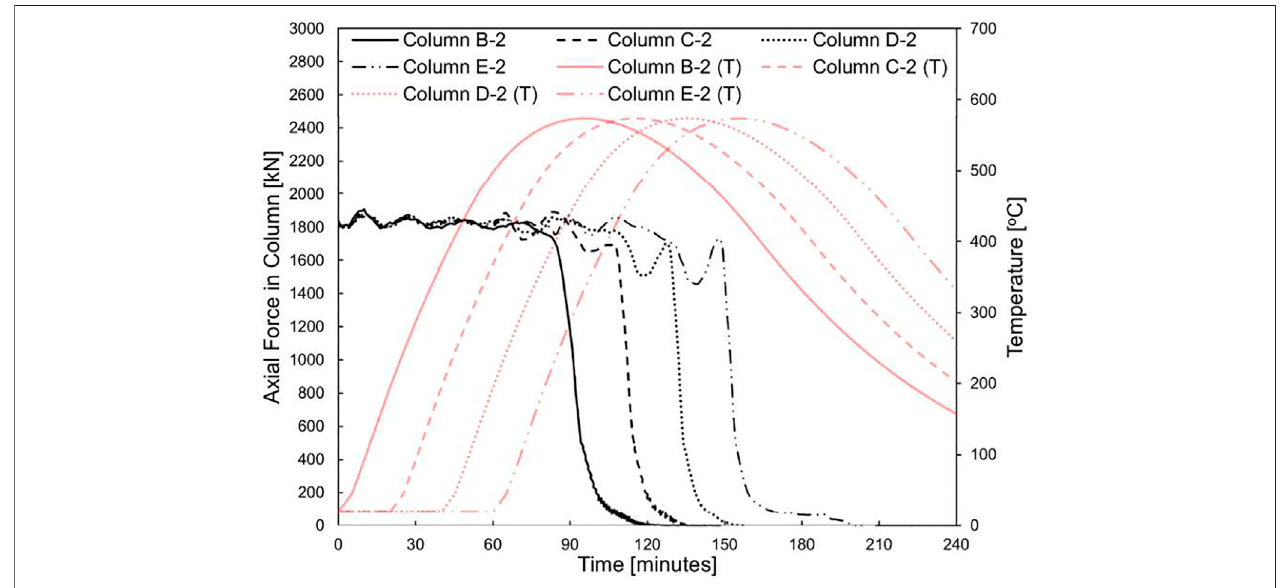
FIGURE 9 | Axial force history of gravity columns in Fire Scenario